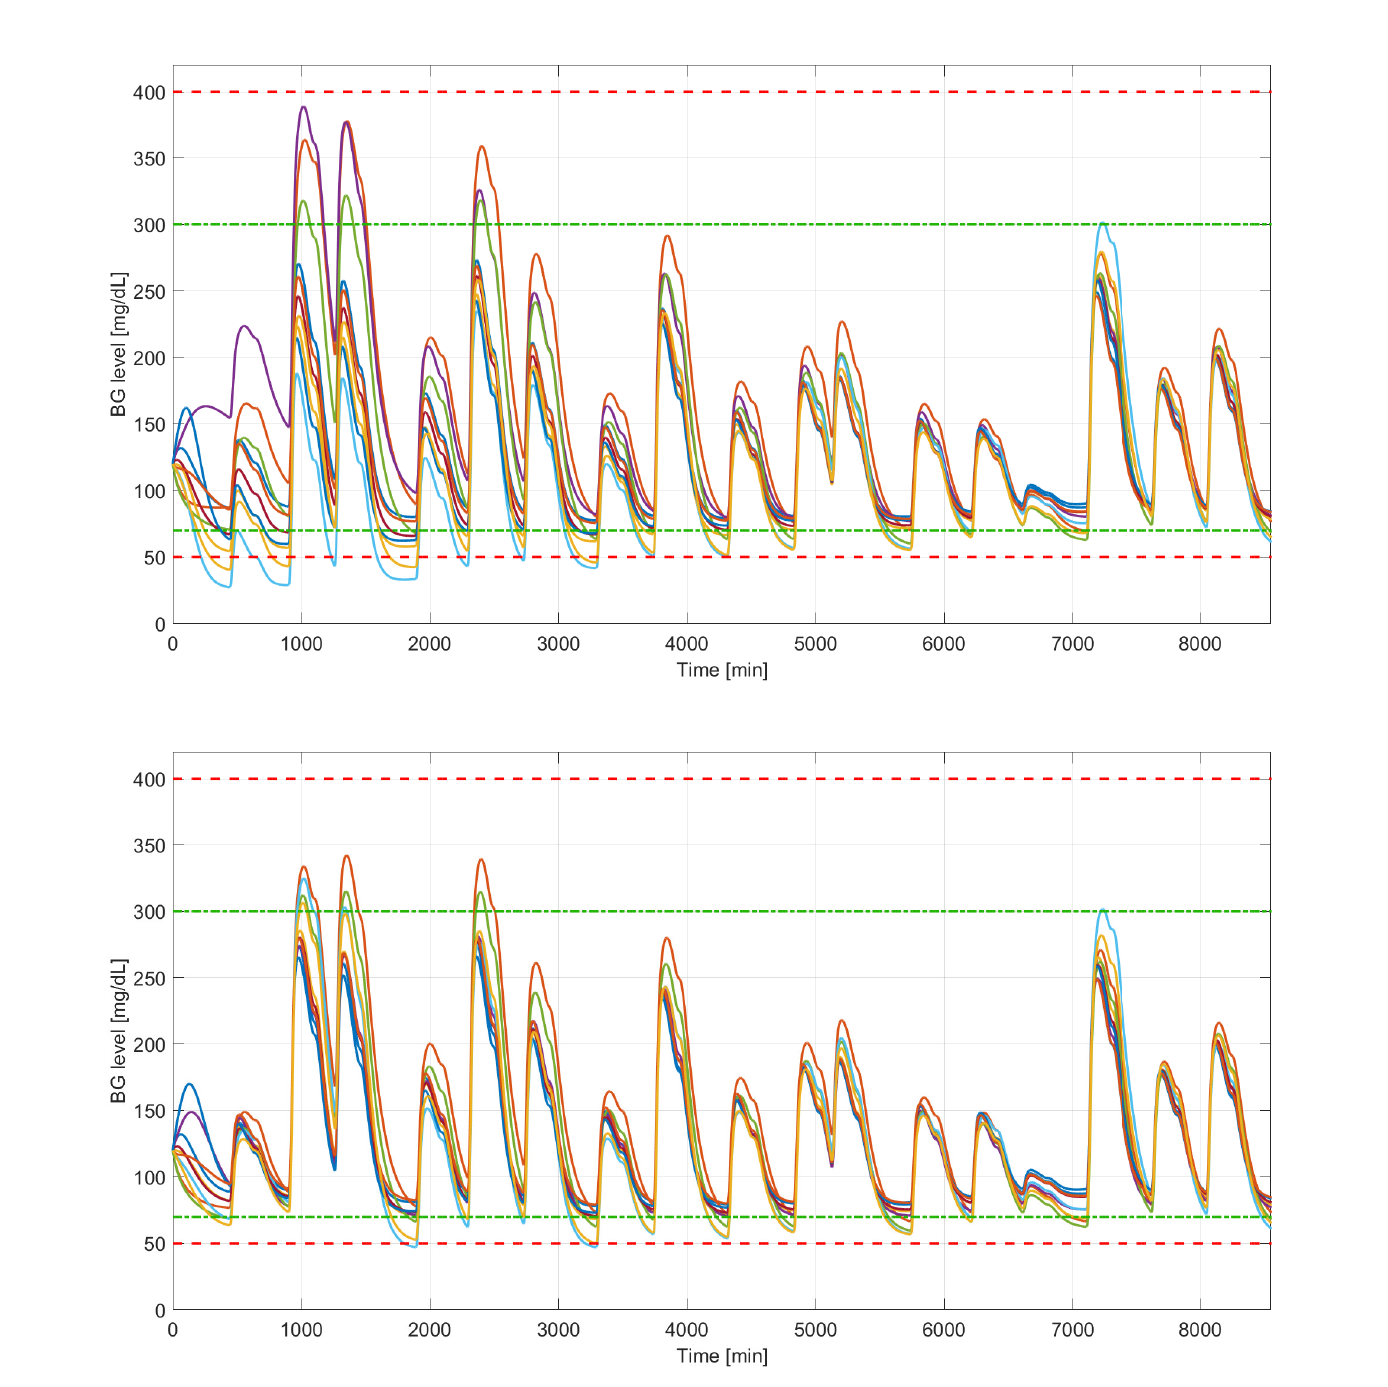
Figure 3. BG levels of the two simulations. The top figure shows the slow adaptation case, while the bottom corresponds to the fast. The red dashed line indicates a tolerable region of BG level, while the green dash-dotted line shows the optimal